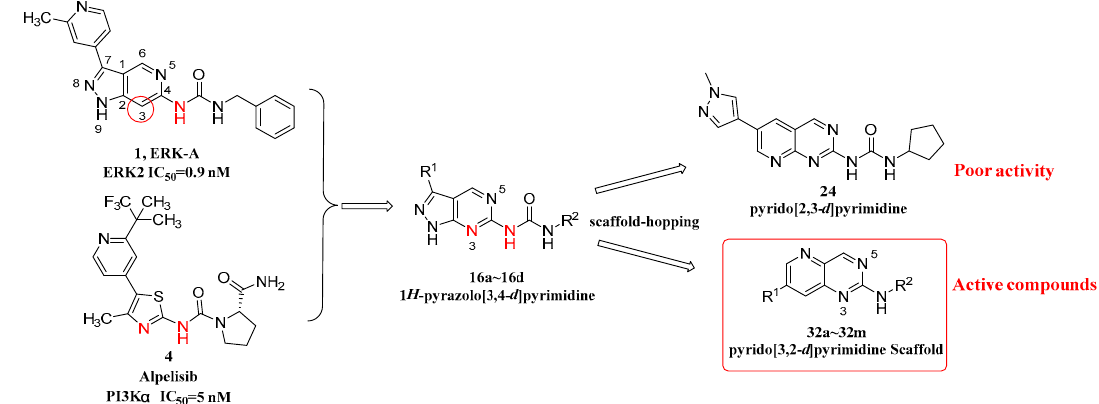
Figure 5. Design of our ERK/PI3K dual from 1 H -pyrazolo[4,3- c ]pyridine to pyrido[3,2- d ]pyrimidine scaffold.